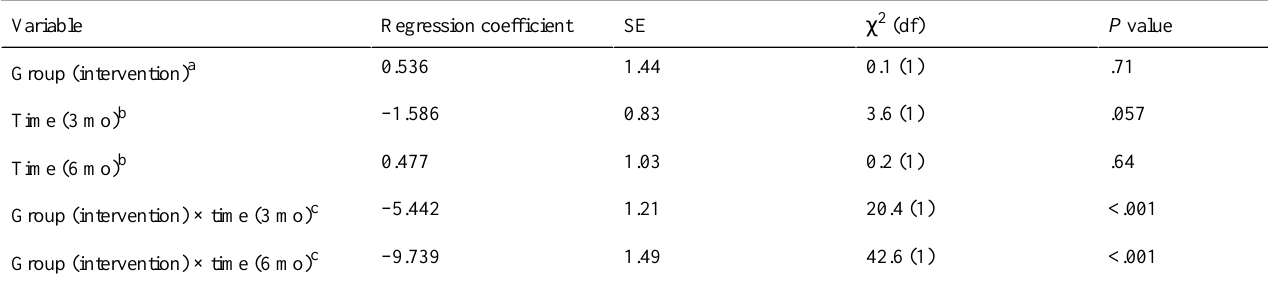
Table 2. Generalized estimating equation analysis of the effect of the intervention on diastolic blood pressure.